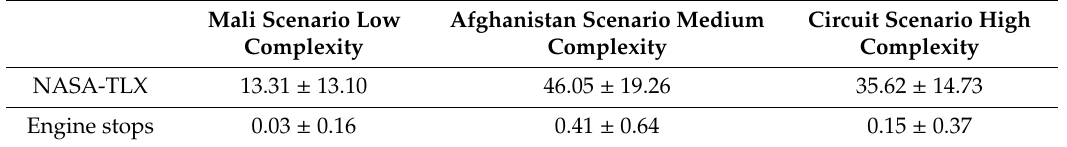
Table 1. Comparison of the means ± standard deviations of the subjective ratings of task load measured by the NASA-Task Load Index (NASA-TLX) and driving performance measured by the number of engine stops for the three simulated mission scenarios ( n = 39). For the NASA-TLX, scores range from 0 to 100, with higher scores meaning a higher degree of task load. The ANOVAs yielded significant e ff ects of the terrain complexity (all p -values <